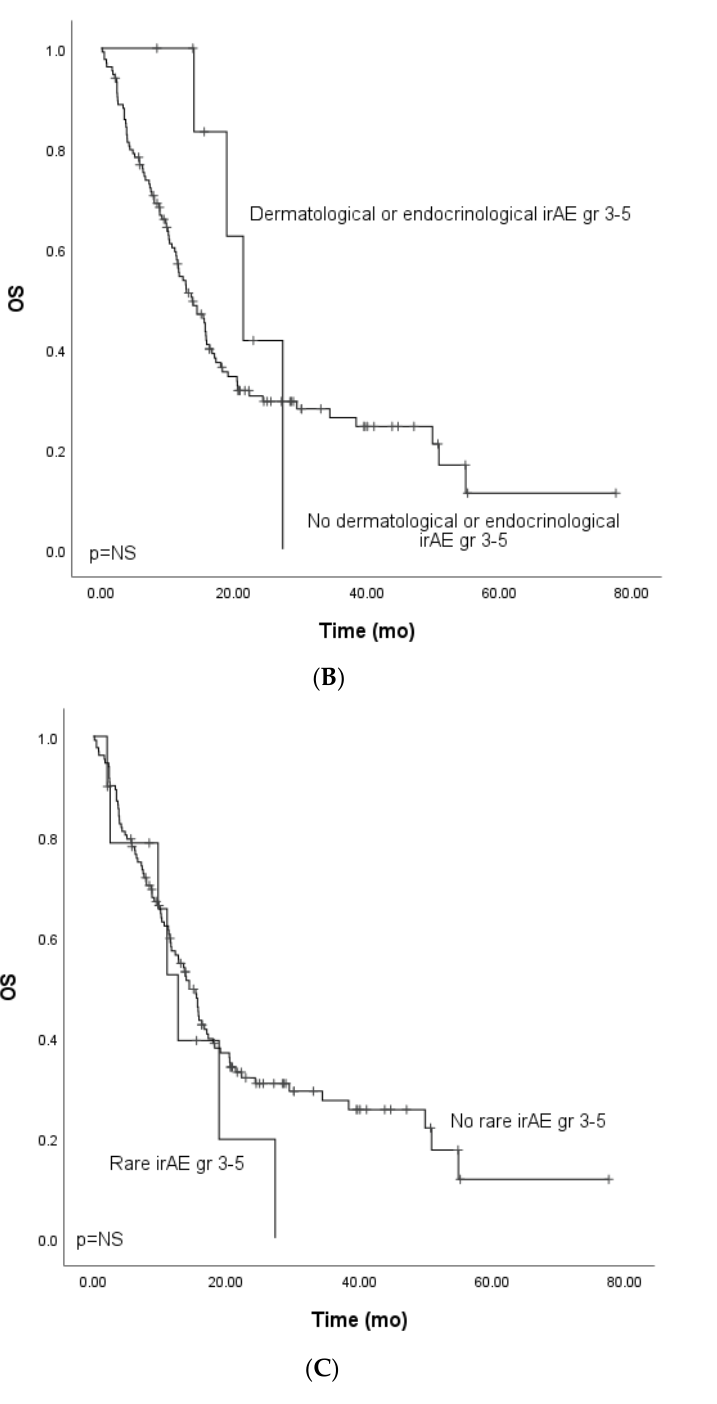
Figure 2. Kaplan–Meier analysis for the overall survival for patients with ( A ) grade ≥ 3 immune- related adverse events; ( B ) grade ≥ 3 dermatological or endocrinological immune-related adverse events; ( C ) rare grade ≥ 3 immune-related adverse events. Crosses indicate censored events.